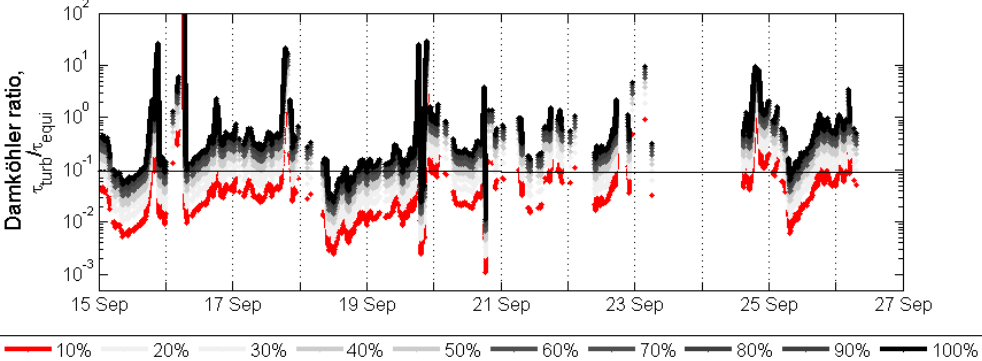
Fig. 3. Results of characteristic timescale analysis: Damk¨ohler number (Da= τ turb / τ equi ) during the EGER campaign (15–27 September 2007). Damk¨ohler numbers for different fractions of the particle surface available for the equilibrium reaction are presented (red line: 10% and black line: 100% of the aerosol surface takes part in the equilibrium reaction).